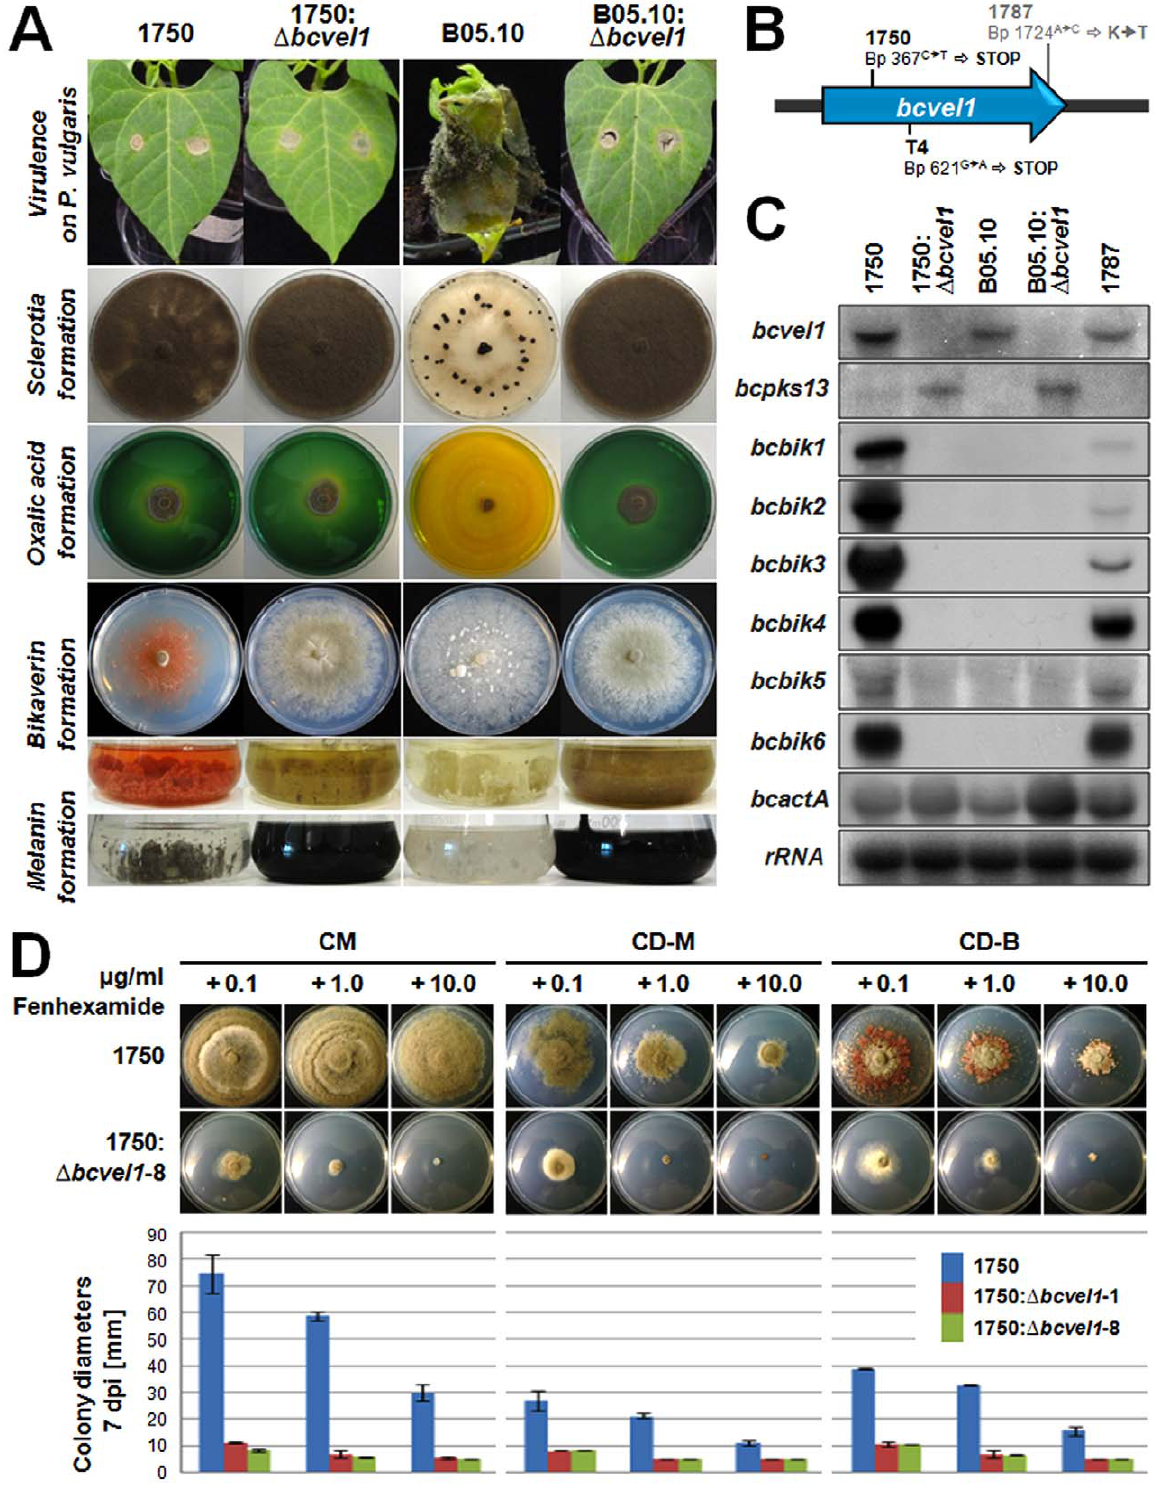
Figure 4. Role of the global regulator BcVEL1 in the pink strain 1750. A. Phenotypes caused by the deletion of bcvel1 in two different genetic backgrounds, 1750 and B05.10. Virulence of strains was monitored on living plants of Phaseolus vulgaris (7 days after inoculation), sclerotial development by incubation on complete medium (CM) in continuous darkness (14 days), oxalic acid production by using the pH indicator bromothymol blue (color change from green to yellow indicate the acidification of the culture medium) (7 days), bikaverin formation by incubation in liquid or on solid CD-B medium in the dark (7 days), and melanin formation by incubation in liquid CD-M medium in light-dark conditions (7 days). B. Sequencing of bcvel1 in the pink strains 1750 and 1787 revealed several SNPs. The point mutation of base pair 367 in 1750 results in a stop codon; a similar mutation leading to a truncated BcVEL1 was recently found in strain T4 [32]. Both 1750 and 1787 comprise additional point mutations that are